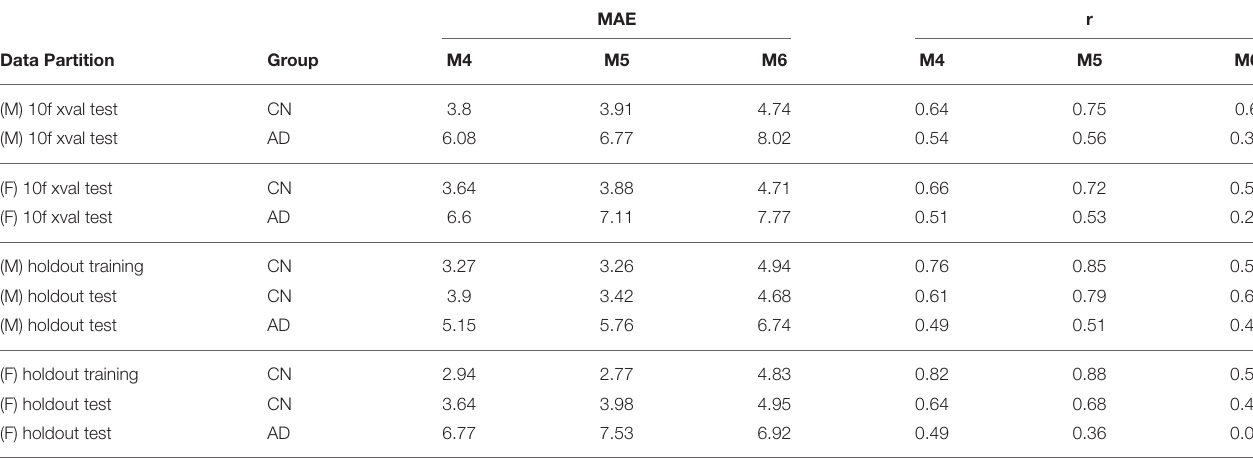
TABLE 4 | Summary of regression results ( MAE , r ) for both gender groups: three incremental versions of the proposed methods with different configurations highlight the contribution of different components.